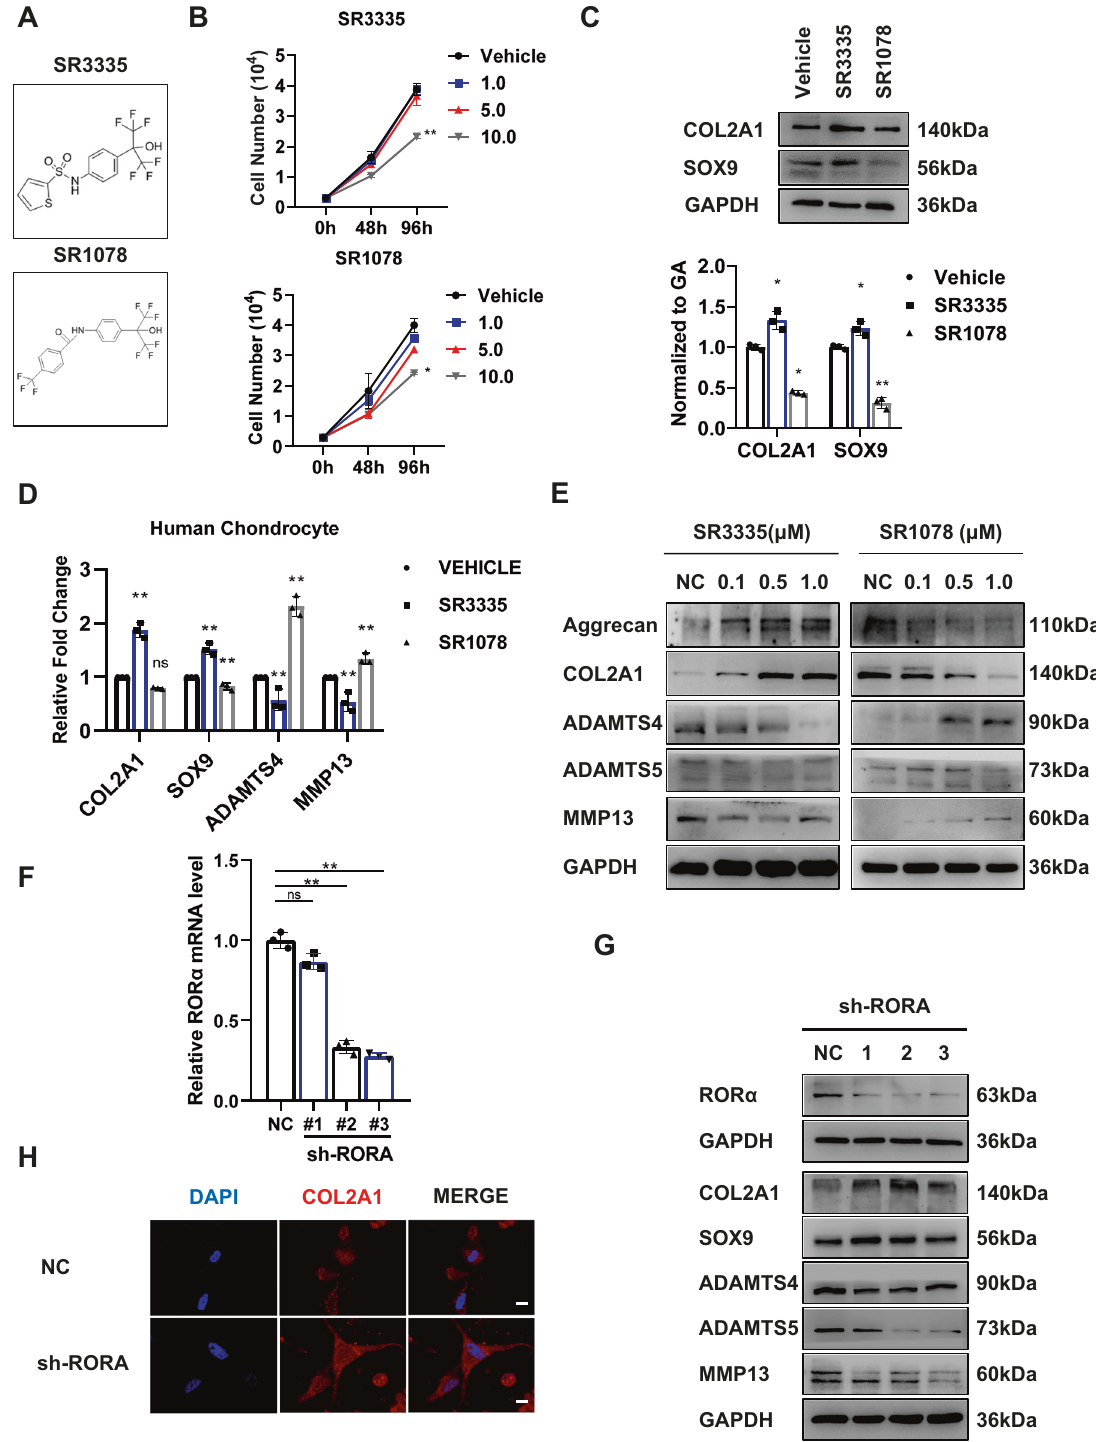
Fig. 3 Manipulation of ROR α via small molecular regulator and siRNA regulated chondrocyte metabolism. A Chemical structures of ROR α antagonist SR3335 and agonist SR1078. B Primary chondrocytes were treated with different concentrations of SR3335 and SR1078 (0, 1, 5, 10 μ M). After the indicated time points, viable cells were counted using CCK-8 assay. C Western blot analysis and quanti fi cation of COL2A1 and SOX9 expression, which are regulated by when treated with 1 μ M SR3335 and SR1078 for 48 h. D The chondrocytes were treated with vehicle, 1 μ M SR1078, or 1 μ M SR3335 for 48 h. The mRNA level of COL2A1 , SOX9 , ADAMTS4 , and MMP13 was determined with real-time PCR. E Western blot analysis of the indicated proteins in human chondrocytes treated with vehicle or the indicated concentration of compounds for 72 h. F The relative expression of RORA gene after infected with sh-RORA or sh-NC lentivirus for 72 h. G , H Western blot analysis and representative immuno fl uorescence images of indicated protein after sh-NC and sh-RORA infection. Scale bars, 20 μ m. Representative blots and images ( n = 3). The statistical data in B were analyzed with one-way ANOVA, data in D and F were analyzed with Student ’ s t test. * P < 0.05, ** P < 0.01, ns = no signi fi cance. All data shown above are presented as mean ± SD.